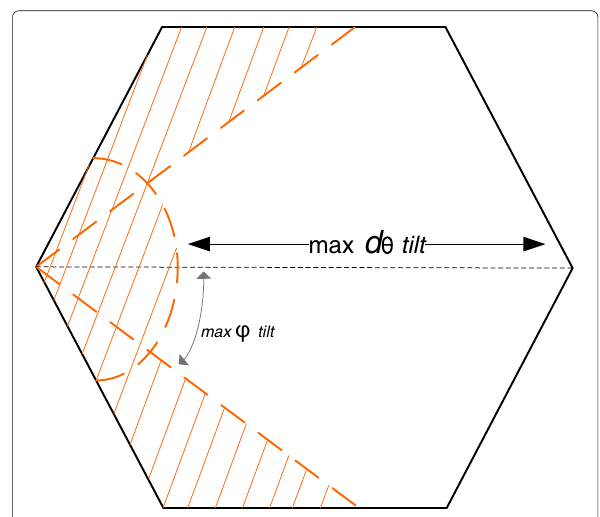
Fig. 3 Constraint location for VSC in hexagonal cell. This figure represents the constraint location in an hexagonal cell where the VSCs can not be deployed